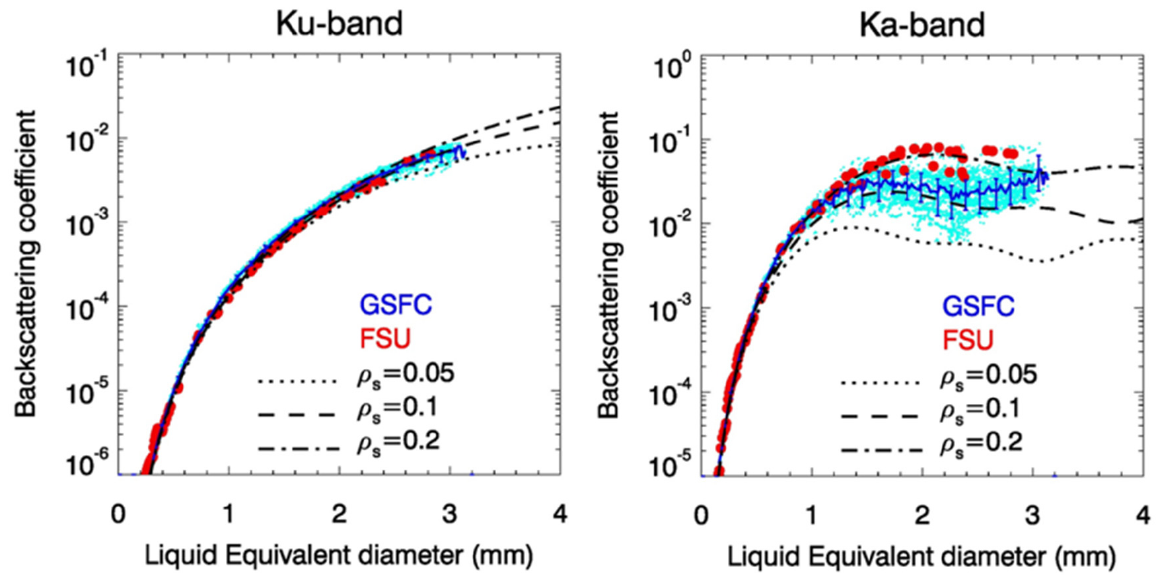
Figure 3. Backscattering coefficients of snow obtained from the GSFC (cyan dot) and FSU (red filled-circle) scattering databases as a function of liquid equivalent diameter at Ku- ( left ) and Ka-band ( right ). The mean (solid blue curve) and twice the standard deviation (vertical blue bar) of the GSFC database are also plotted. The scattering results computed from the randomly oriented oblate-spheroidal models with an aspect ratio of 0.6 are provided for densities of 0.05, 0.1, and 0.2 g/cm 3 , denoted by dotted, dashed, and dotted-dashed curves, respectively.